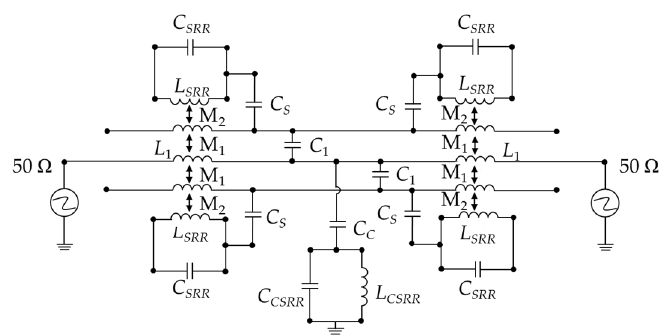
Figure 4. The equivalent circuit of the sensor. The electrical parameters are C SRR = 0.258 pF, L SRR = 1.031 nH, C S = 0.157 pF, L 1 = 3.471nH, C 1 = 0.347 nH, Cc SRR = 0.258 pF, L CSRR = 1.031 nH, Cc = 0.157 pF, and C SRR = 0.258 PF.